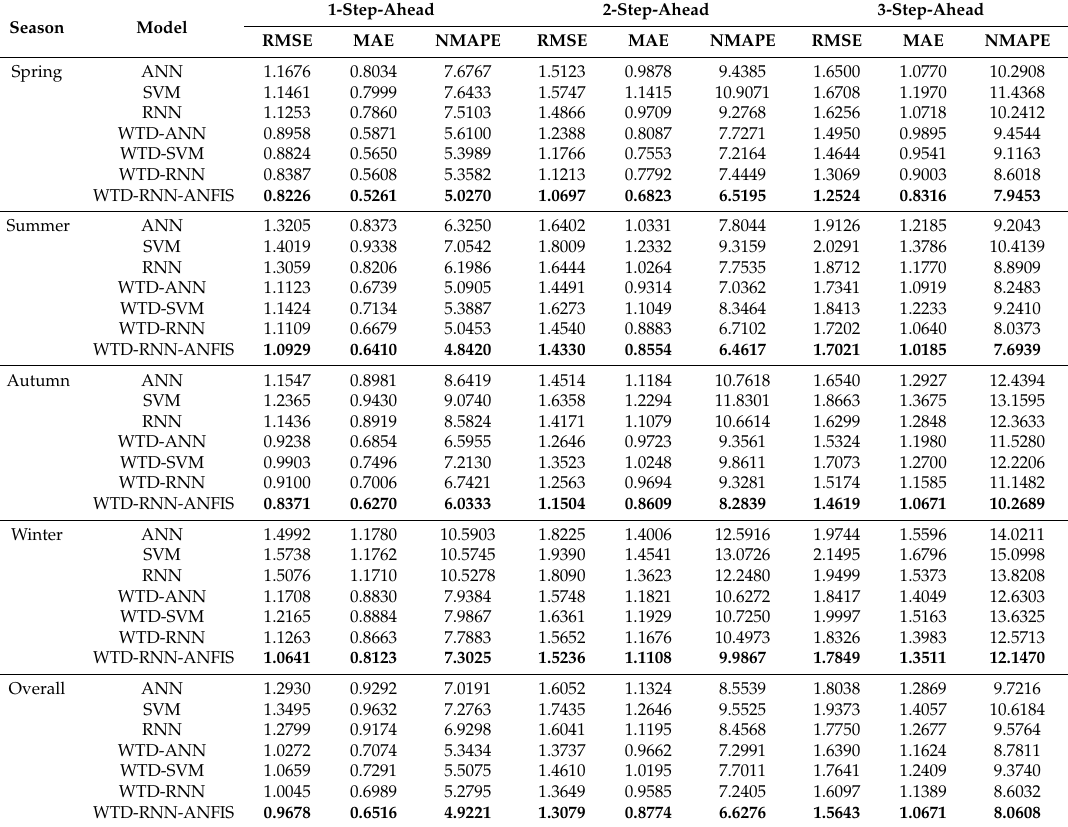
Table 4. The performance criteria of different models for point wind speed